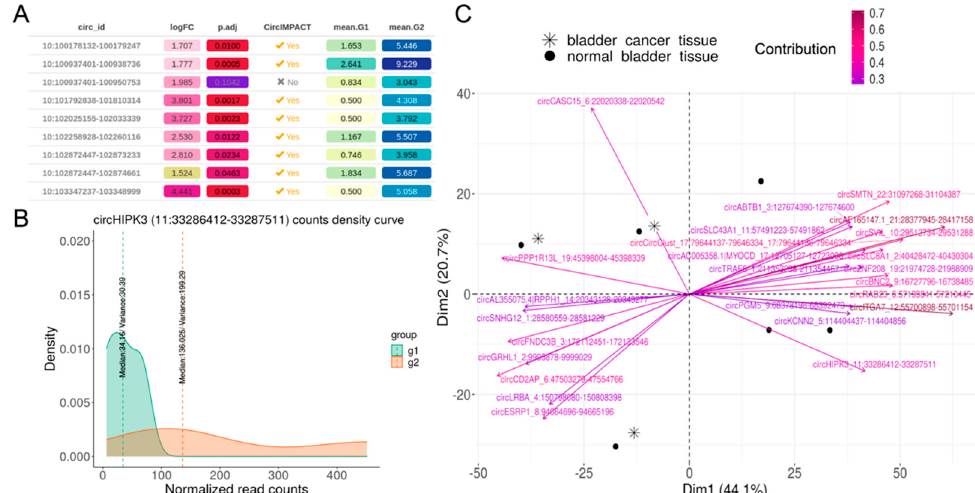
Figure 3. CircRNA analysis of bladder cancer RNA-seq data. ( A ) Fragment of the table produced by the circ.marker function, indicating circRNAs equally or differentially expressed among sample groups. ( B ) Density plot for circHIPK3 expression in the sample groups defined by circHIPK3 median expression (g1 corresponds to bladder cancer, g2 to control samples). ( C ) Principal component analysis (PCA) of the sample separation using the top 25 circRNAs mainly contributing to sample separation, which include